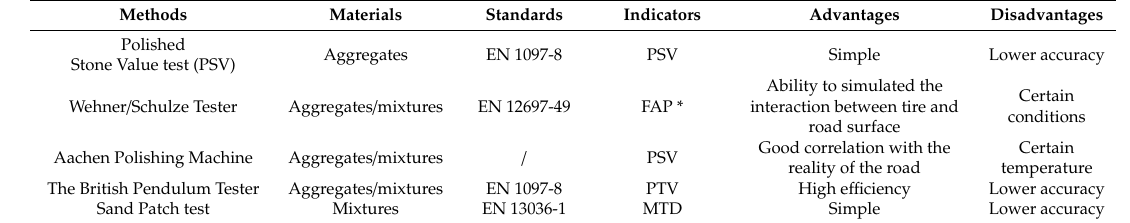
Table 6. Polishing property test method of aggregates and asphalt mixtures